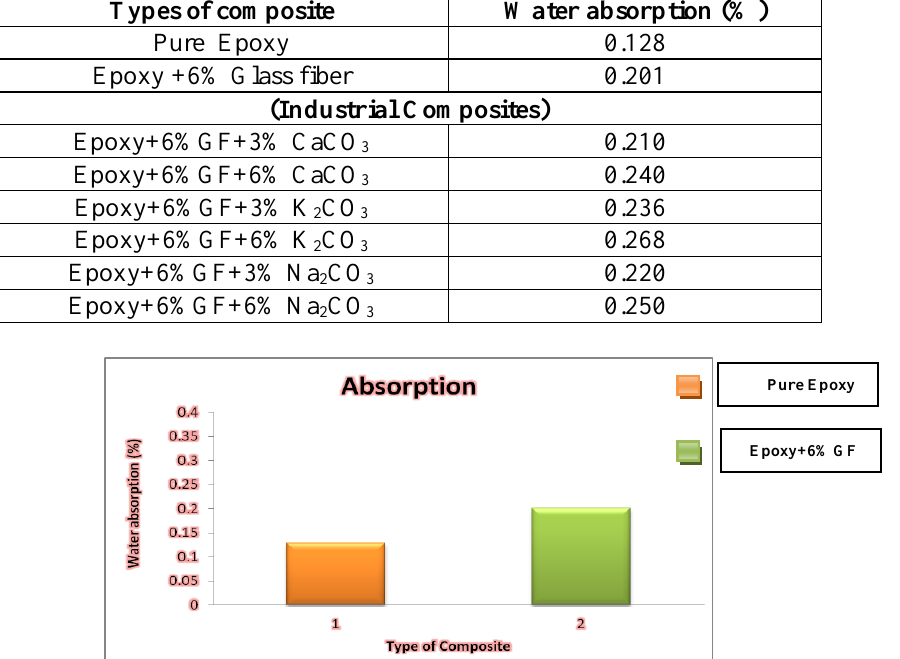
Table 3: Water absorption of the prepared composites.